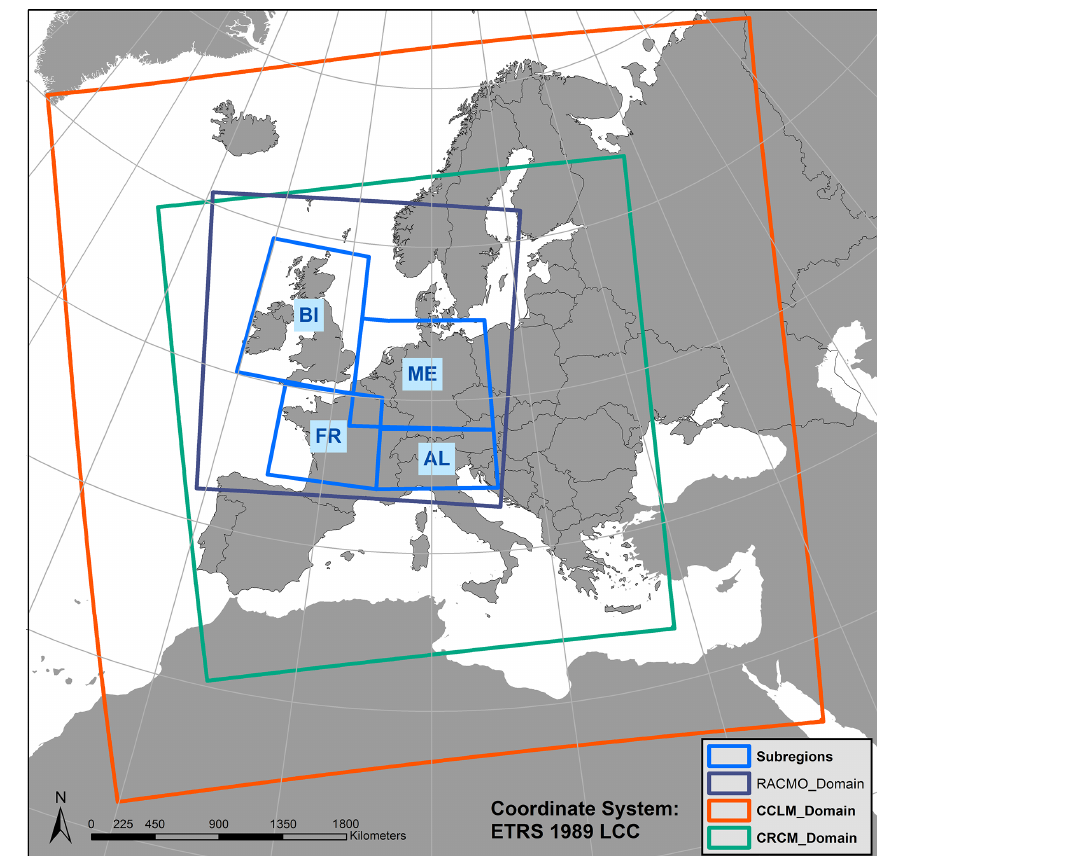
Figure 1. Domains of the three RCMs and the boundaries of the four analysis regions; BI: the British Isles; FR: France; ME: mid-Europe; AL: Alps; the CCLM domain matches the EURO-CORDEX